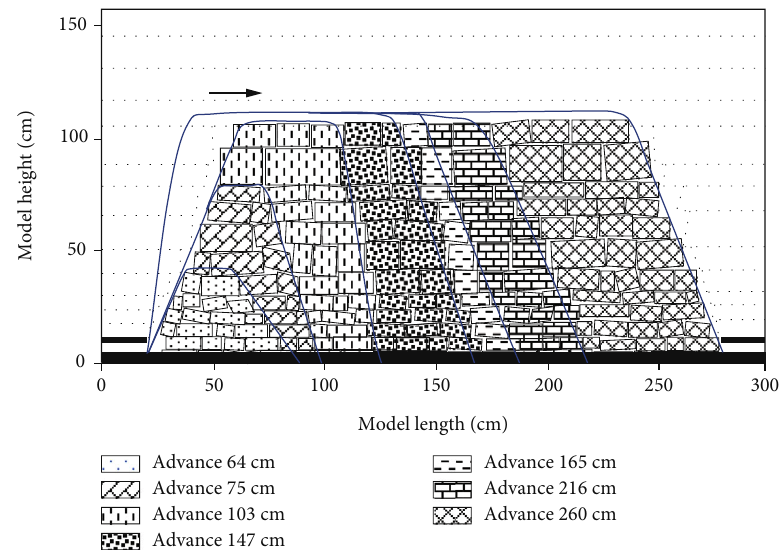
Figure 14: Evolution of overburden structure of the 4-2 coal seam.